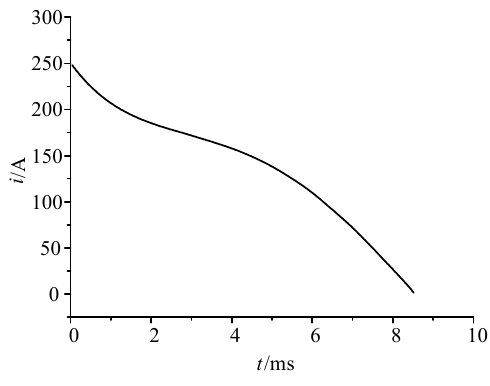
Figure 6. Arc current curve.